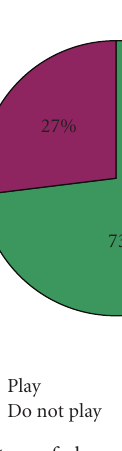
Figure 4: Percentage of players who play each game genre.